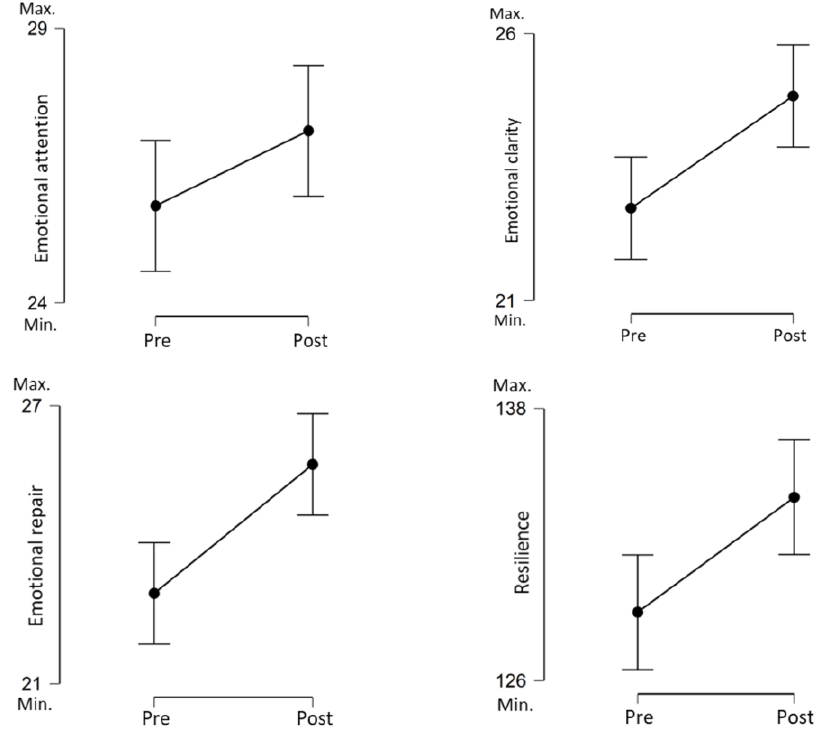
Figure 2. Emotional intelligence and resilience. Descriptive